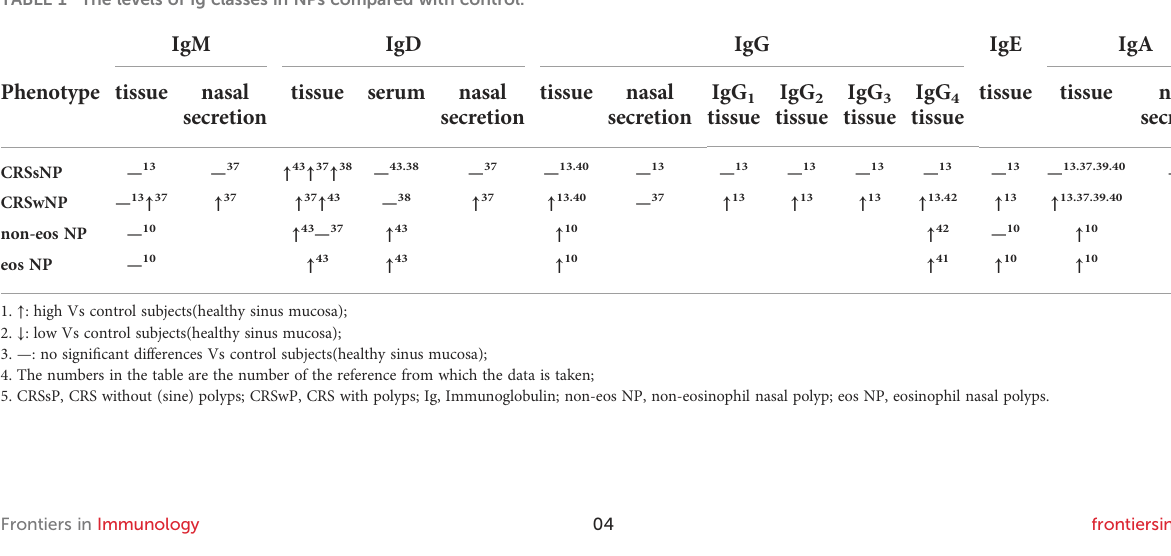
TABLE 1 The levels of Ig classes in NPs compared with